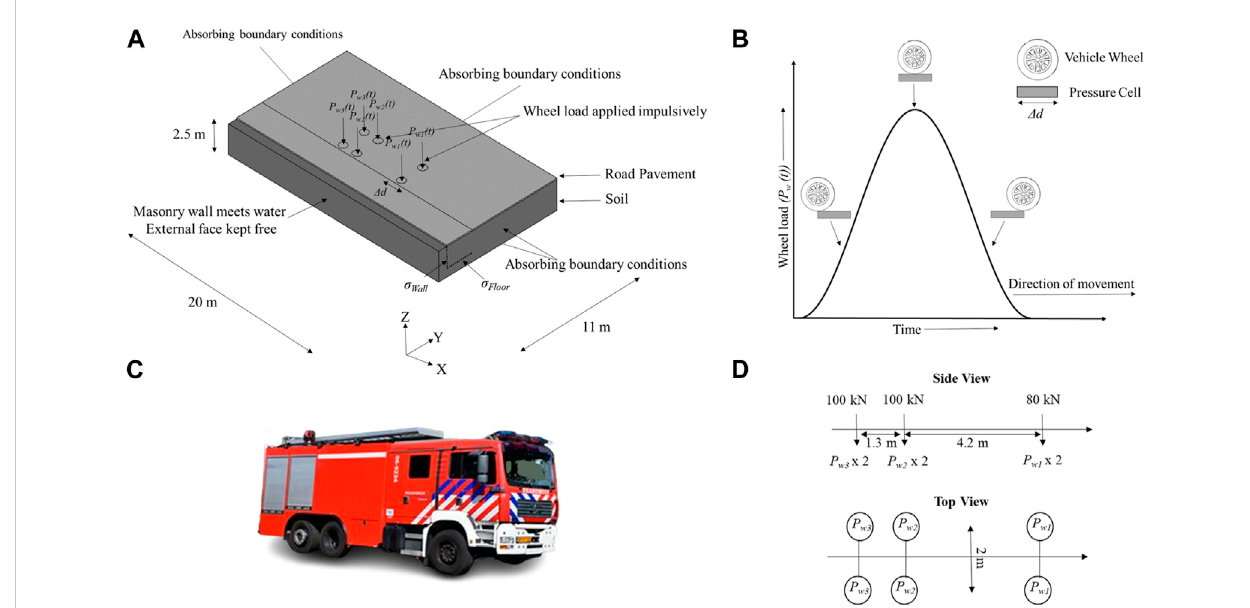
FIGURE 2 (A) Numericalmodeladoptedfortier1,fora3axle,6wheeled fi retruck; (B) relationbetweenawheelloadimpulse( P w (t) )andthepassageofawheel over a distance Δ d ; (C) the 3 axle, 6 wheeled fi re truck used in Amsterdam and (D) schematic representation of the wheel loads associated with the fi re